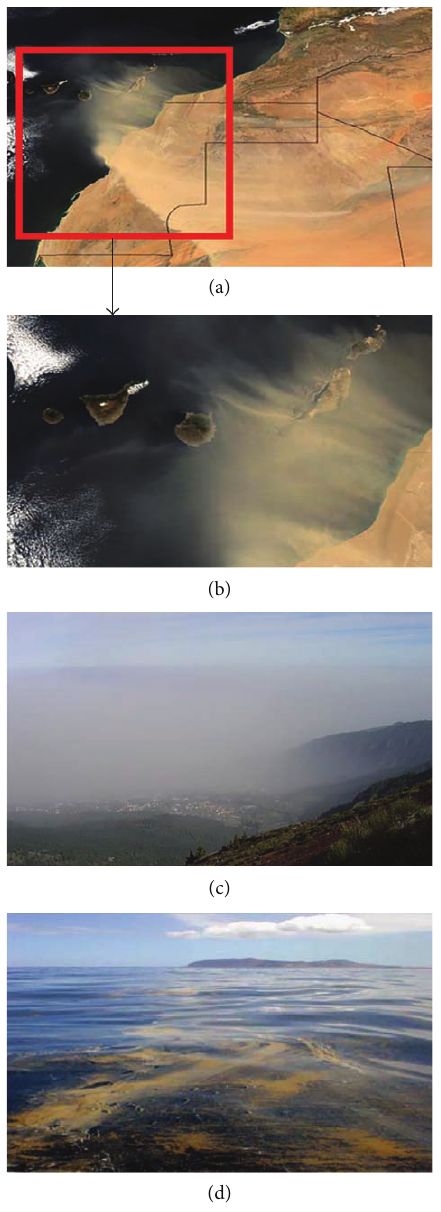
Figure 14: Moderate Resolution Imaging Spectroradiometer detected Saharan dust storm of Northwest Africa above Canary Islands. (a) MODIS image with 2000 m resolution and (b) MODIS image with 250 m resolution. Images were taken from Visible Earth (2004). (c) Desert dust of West Africa out over Canary Island during 3 March 2004, photo: “Eugenio Rodriguez 03 March (2004)” and (d) dust over coast Gran Canaria, may be associated with Saharan dust storm of North Western Africa